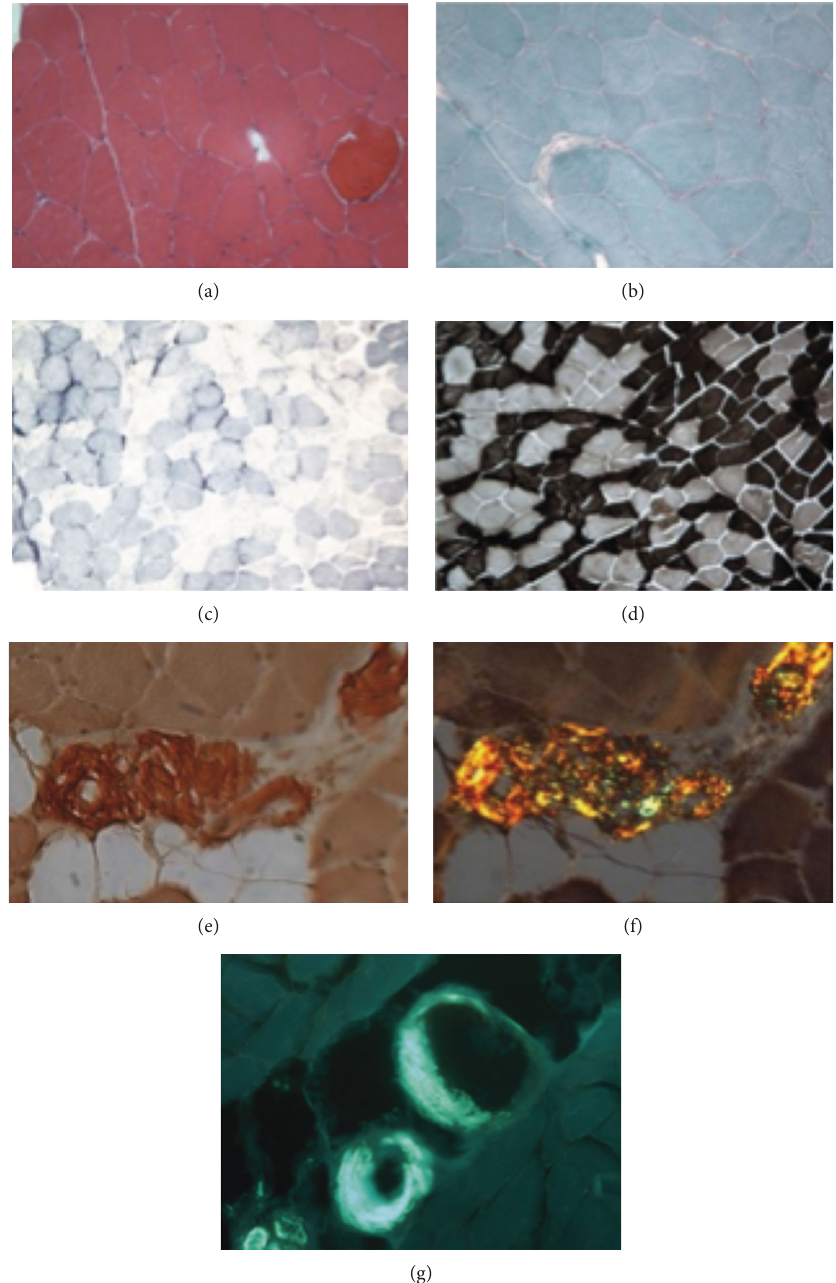
Figure 1: Muscle biopsy general features and the presence of amyloid substance. (a) Hematoxylin and eosin staining: the muscle cells show regular morphological characteristics with the exception of one hypercontracted cell; (b) Gomori staining: normal histological picture; (c) succinate dehydrogenase staining (SDH): the staining shows mild changes in myofibrillar texture; (d) ATPase pH 9.4: normal muscle fiber typing and distribution. Congo red staining without (e) or with polarized light (f): presence of amyloid around/inside the wall of perimysial vessels ( × 20); (g) Thioflavin S staining with fluorescence microscope: amyloid substance appears bright green in dark field. It completely includes the vessel wall of some perimysial arterioles ( ×